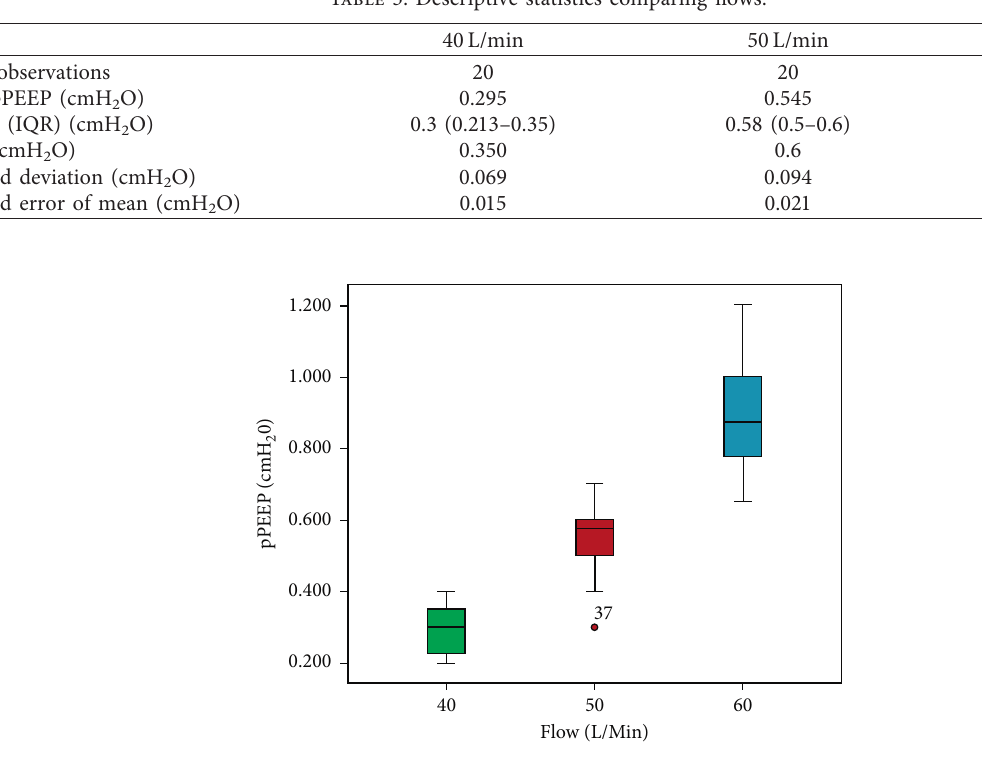
Figure 3: Box plots of pPEEP in cmH 2 O with 40L/min, 50 L/min, and 60L/min flows.